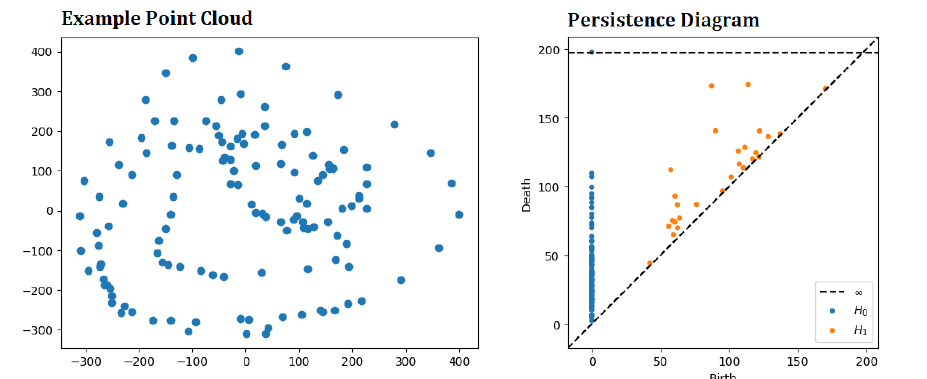
Figure 3. Representation of Point Cloud—RPC ( left ) on a Persistence Diagram representation—PDR ( right